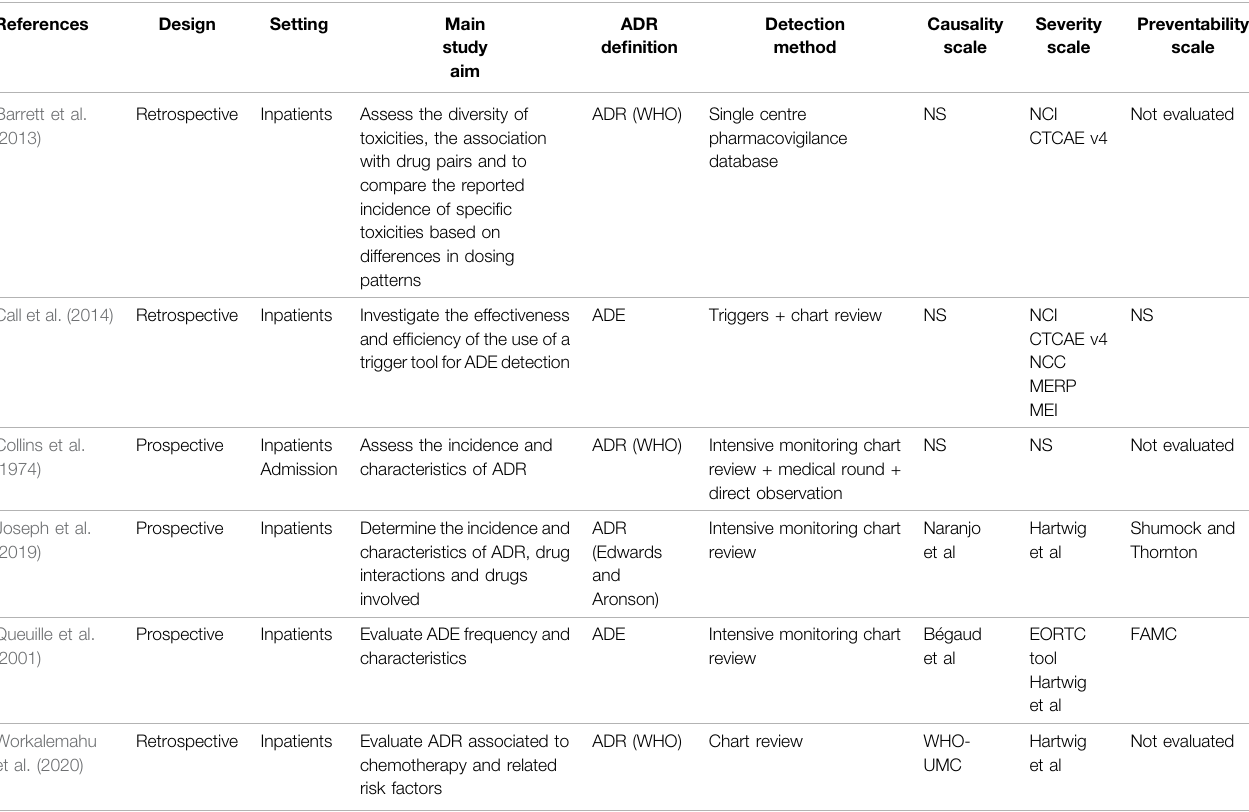
TABLE 1 | Methodology characteristics in pediatric oncohematology